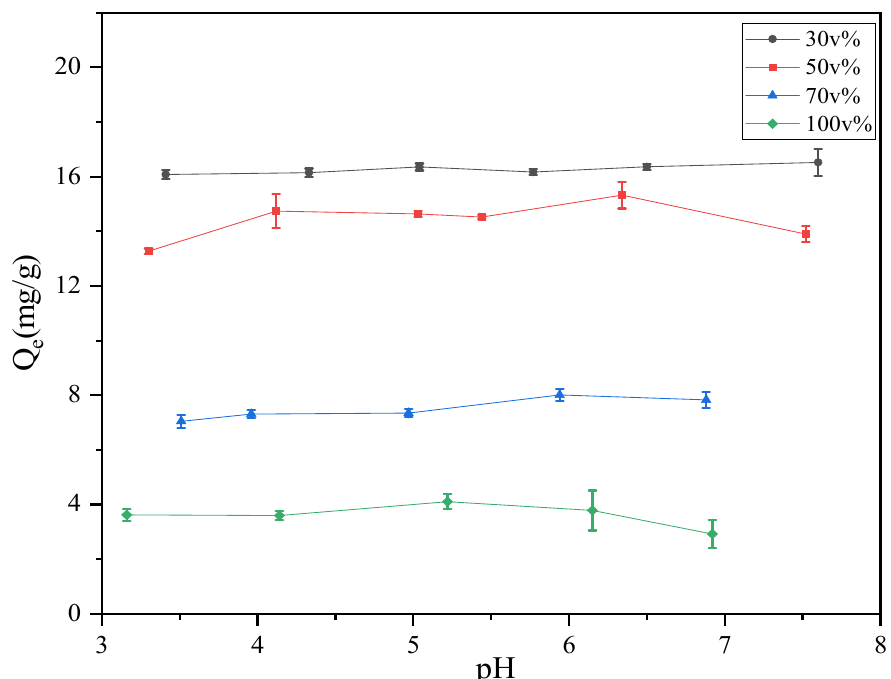
Figure 1. The effect of the solution pH on the adsorption capacity for DBP. Each volume fraction in the legend in this paper is the ethanol